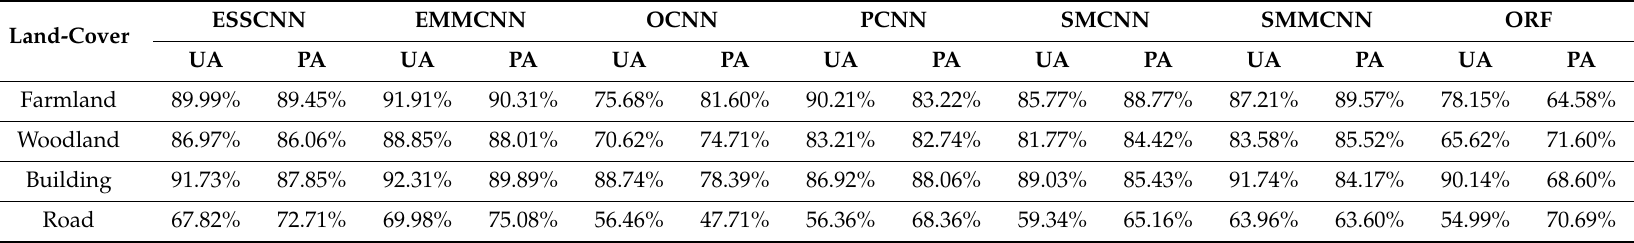
Table 10. Classification accuracy comparison amongst ESSCNN, EMMCNN, OCNN, PCNN, SMCNN, SMMCNN, and ORF methods for the Xiaoshan testing samples.